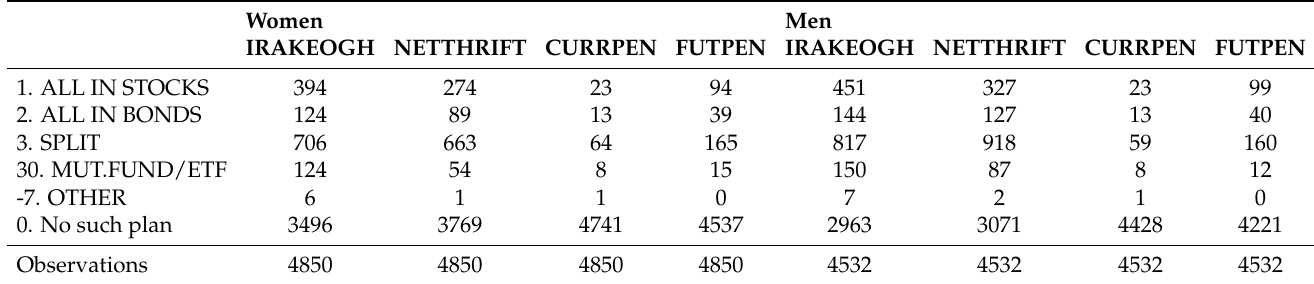
Table 6. How Do Women and Men Invest Their Retirement Wealth? Women